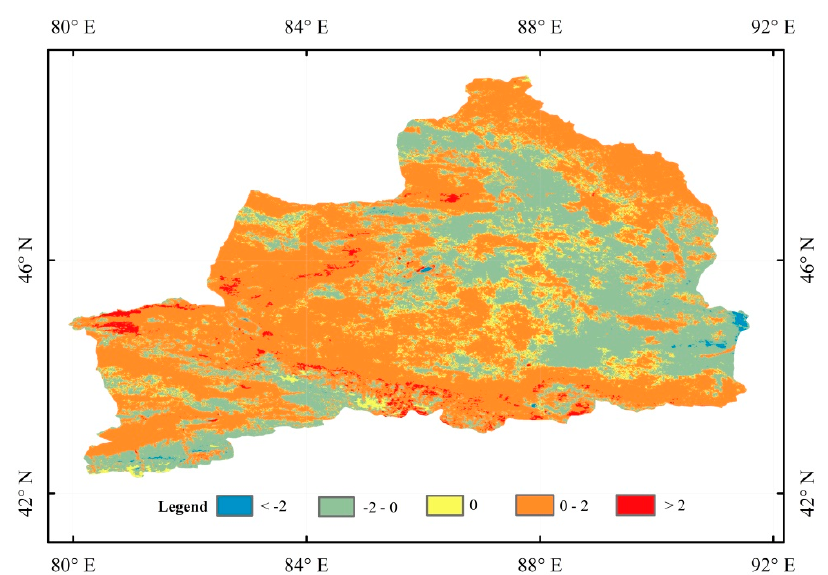
Figure 10. Variation slope of the SCD in northern Xinjiang, China based on Sen’s median method from 2001 to 2018.